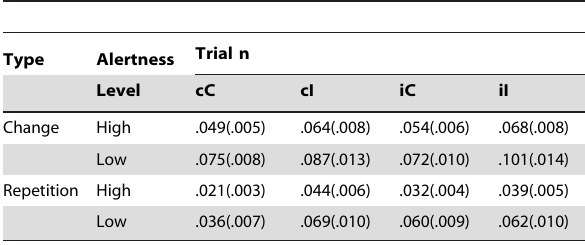
Table 3. Error rates (SE) for Transitions of Previous 6 Current Trial